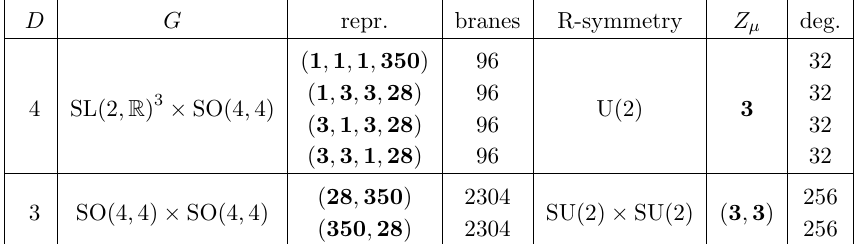
Table 3 . The number and the degeneracy of 1/2-BPS space-(cid:12)lling branes of the quarter-maximal theories resulting from Z 2 truncations [21] (see also tables 7 and 8 of